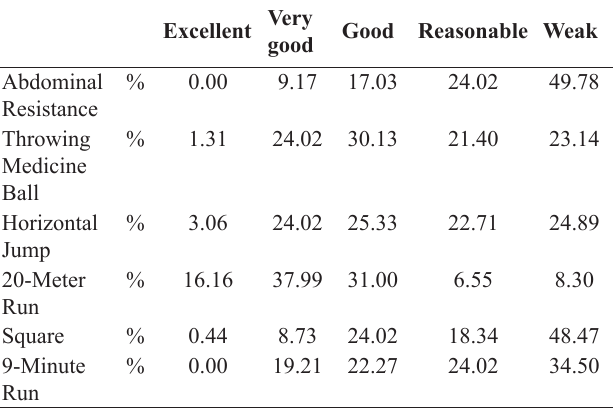
Table 2. Performance of PROESP-BR tests of 229 male students from 15 to 17 years of age from Public Network state schools in Cuiabá- MT, Brazil.